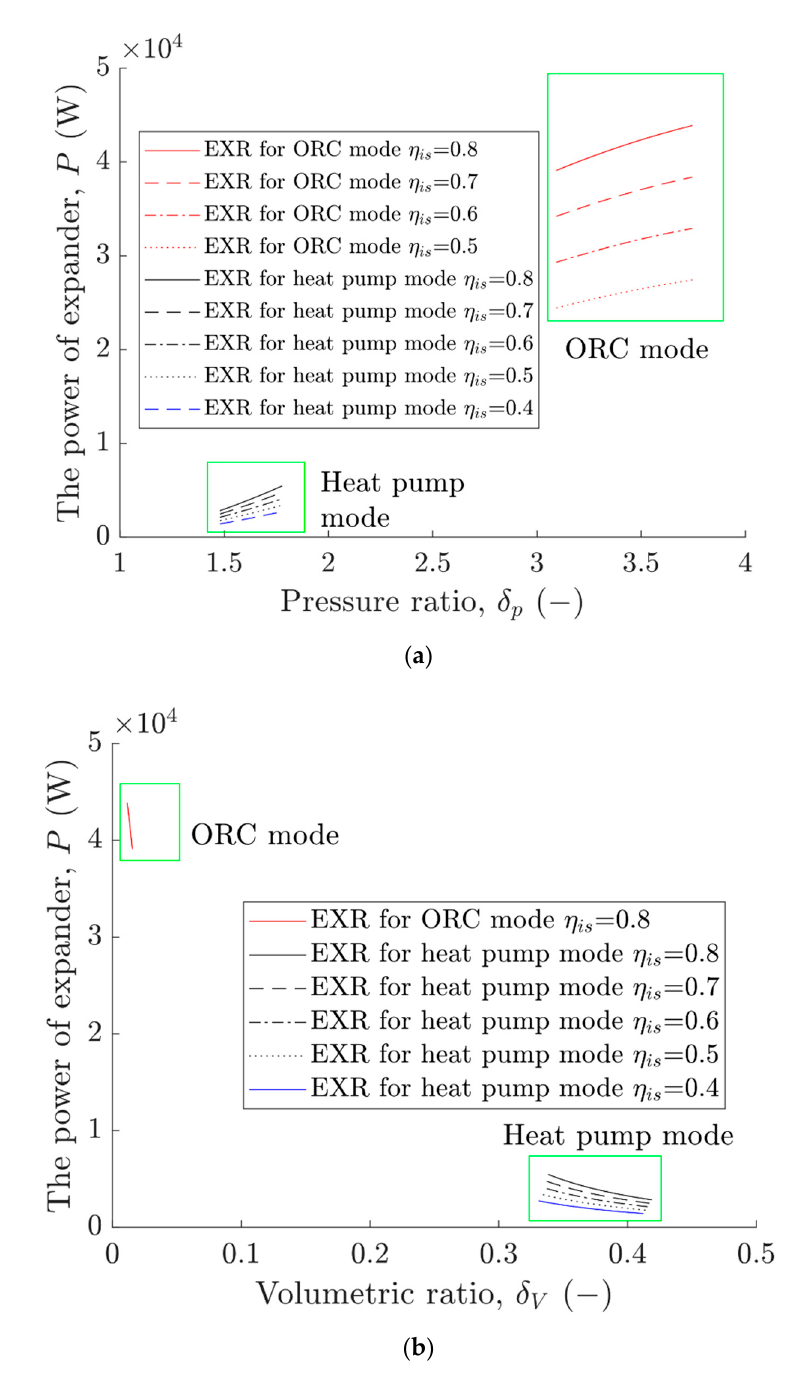
Figure 3. The obtained power of the two-phase expander applied in the RRTC in ORC and heat pump modes in ( a ) pressure ratio–expander power diagram and ( b ) volume ratio–expander power diagram. Because the throttle valve is replaced by a volumetric expander in the RRTC heat pump, the power of the expander can be calculated not only for the ORC mode, but also for the heat pump mode.